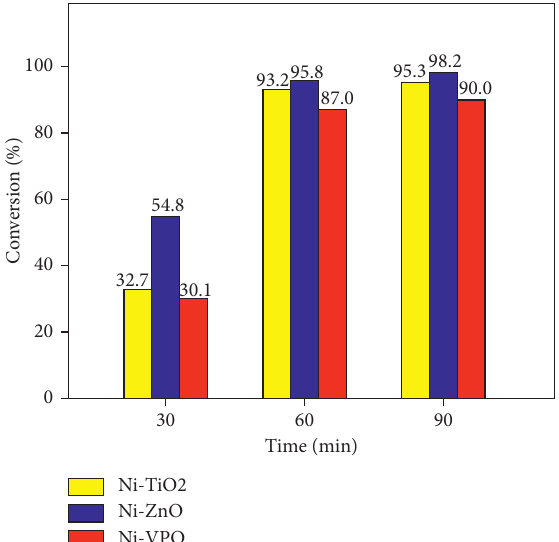
Figure 5: Conversion of 3-chlorophenol over Ni-X catalysts vs. time reaction.